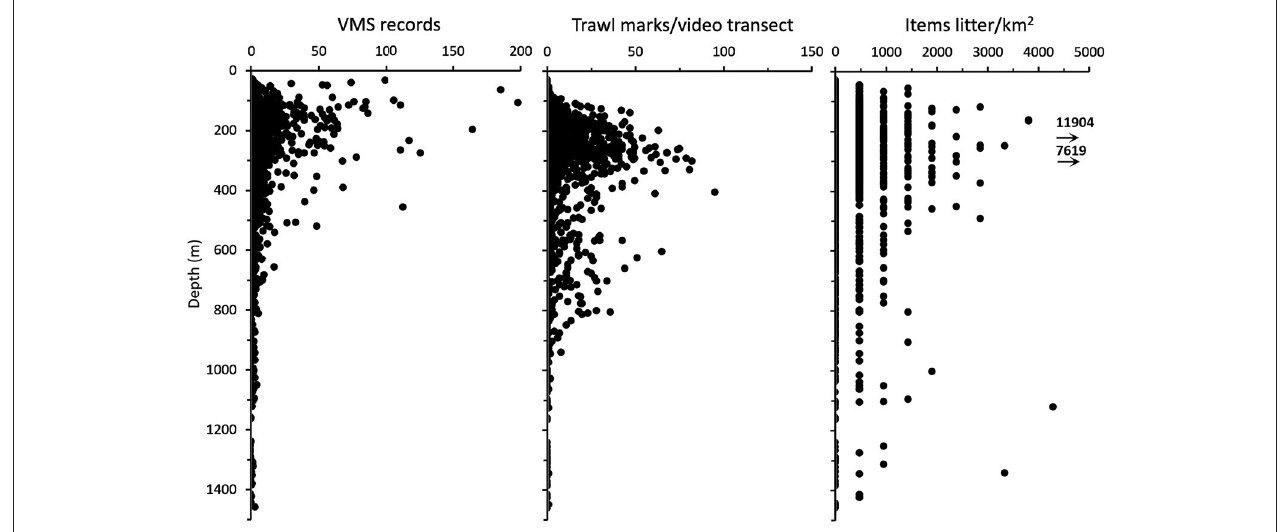
FIGURE 3 | Bathymetric distribution of VMS records (mean values of records per year for 3 years prior to video surveys). Observed trawl marks, and density of observed litter items.